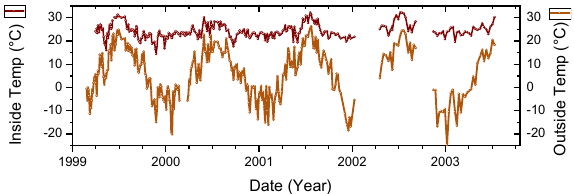
Figure 9. Comparison of daily average outside temperature from a weather station in Moscow 40 with inside temperature in the laboratory measured by Parkhomov. The inside temperature is more stable, yet also rises above average during the summer peaks.